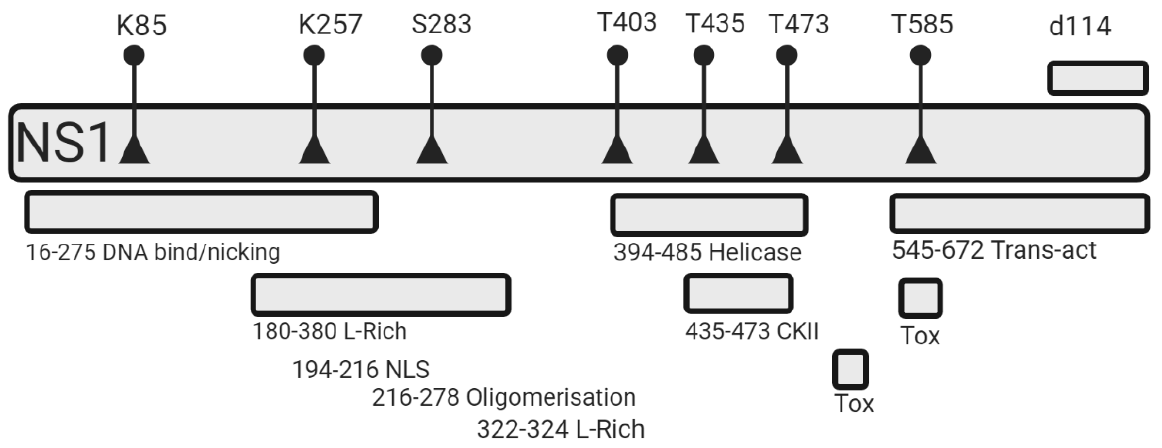
Figure 1. Schematic overview of non-structural protein 1 (NS1) domains and mutation sites. The non-structural parvovirus-derived protein NS1 is comprised of 672 amino acids. Amino acid positions of previously described functional domains within the NS1 protein are summarized: A site-specific DNA binding domain involved in site- and strand-specific nicking (16–275), an L-Rich area which was shown to be crucial for NS1-mediated toxicity (180–380), a nuclear localization signal (194–216), a motif controlling self-assembly into oligomers (216–278), a helicase domain including a NTP-binding pocket (394–485), a region binding CKII α (435–473), whose interaction is needed for many NS1- signaling pathways, two toxicity domains crucial for NS1 cytotoxicity, and a transactivator domain (545–672), which positively regulates the expression of viral proteins [22]. The locations of specific acetylation [15] and phosphorylation [13,14] sites, where single amino acid mutations and a deletion of 114 nucleotides (d114) [18] were introduced during this work, are indicated. Mutations were introduced by site-directed mutagenesis. For a review see Nüesch et al. [2,10,22].